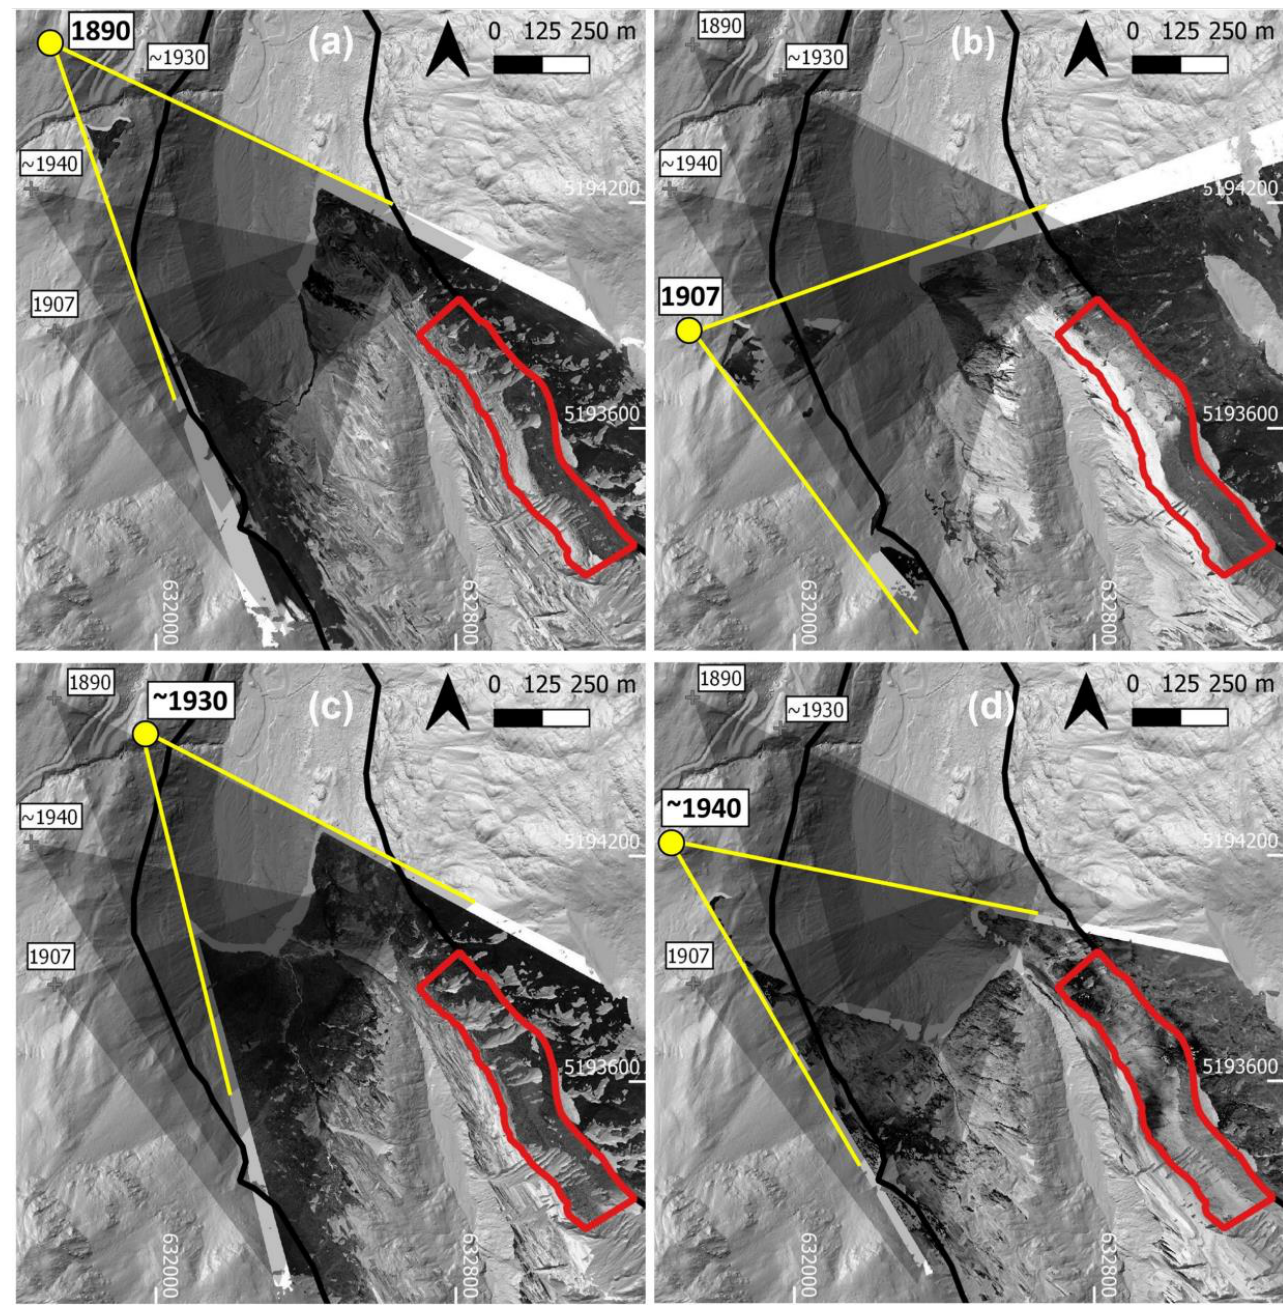
Figure 4. Determination of the position and field of view (yellow marking) of the individual historical terrestrial oblique photographs computed with Mono3D: ( a ) 1890, ( b ) 1907, ( c ) ~1930 and ( d ) ~1940, whereas the black line determines the glacier extent at the end of the LIA and the red polygon the AoI. The historical orthophotos are projected on the hillshade of 2017 published by Piermattei et al. [20]. Table 2. Calculated coordinates of the projection centre (east [E], north [N], height [H]) and the corresponding height above ground [H Ground ], rotation angle of the camera (Alpha, Zeta, Kappa), coordinates of the principal point (x0, y0) and focal length f. σ_0 represents the mean reprojection error. The corresponding standard deviations are given in brackets. The coordinates refer to the ETRS89/UTM Zone 32N coordinate system (EPSG code: 25832). Estimation of Interior and Exterior Orientation